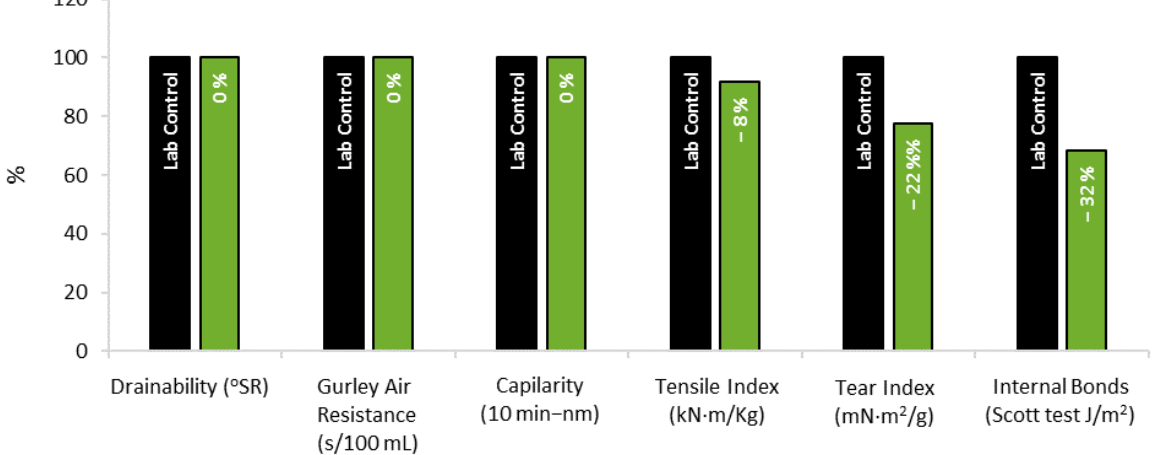
Figure 7. Papermaking properties obtained for the pulp bleached with the Xyn11-assited sequence with 15% ClO 2 savings (green) in relation to the control (with no xylanase addition) at pilot scale. The effluents generated by the EXZ-assisted (EXZD 0 EpD 1 ) and reference